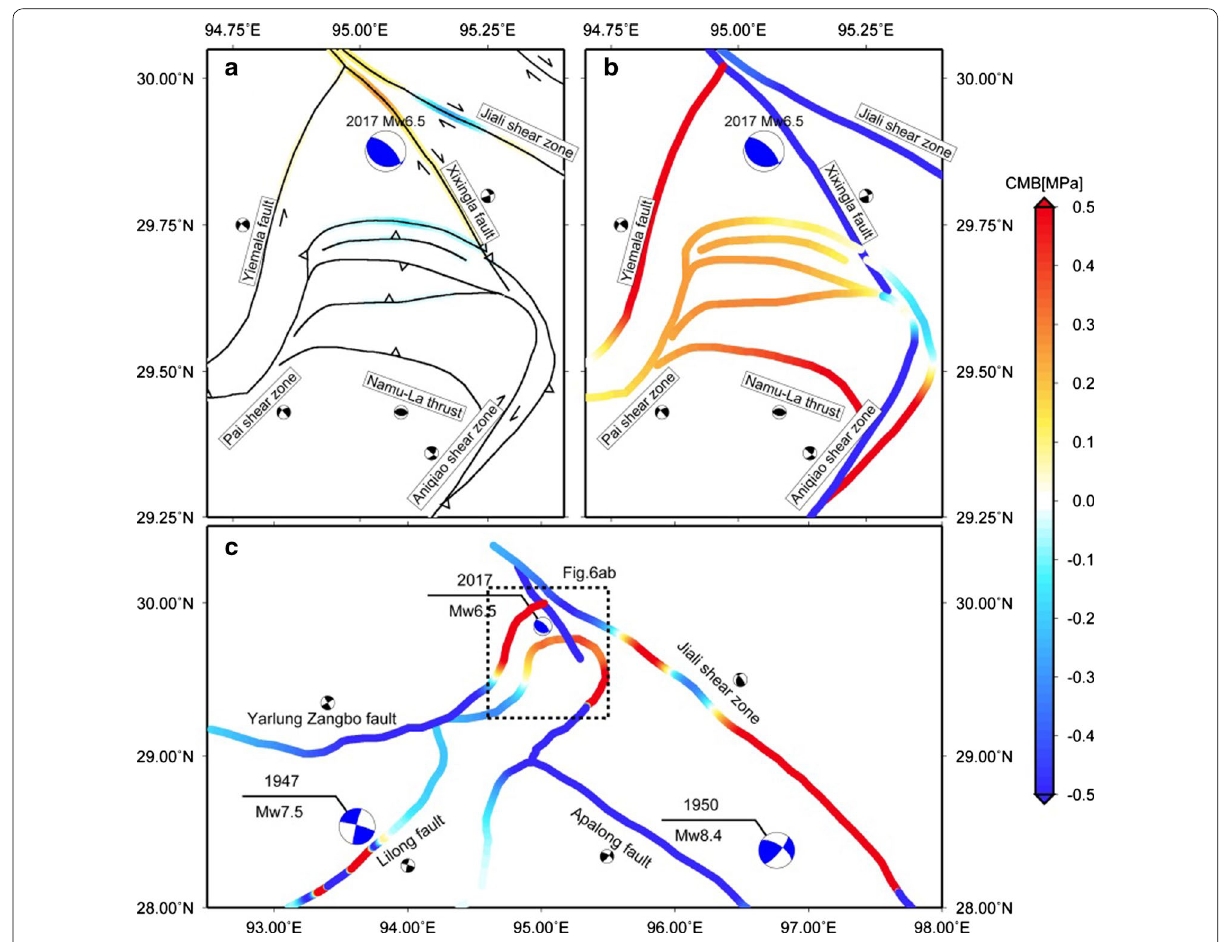
Fig. 7 a Coulomb stress change on surrounding faults caused by the 2017 Mainling earthquake; b , c combined Coulomb stress changes on surrounding faults in different areas caused by the 1947 Lang earthquake, the 1950 Zayu earthquake and the 2017 Mainling earthquake. The dotted line box indicates the extent of Fig. 7a, b. The blue focal spheres represent the focal mechanisms of the historical earthquakes. The black focal spheres near the fault names represent the slip mechanisms of the faults, and the parameters (Additional file 1: Table S1) are selected from Ding et al. (2001) and Yin et al.